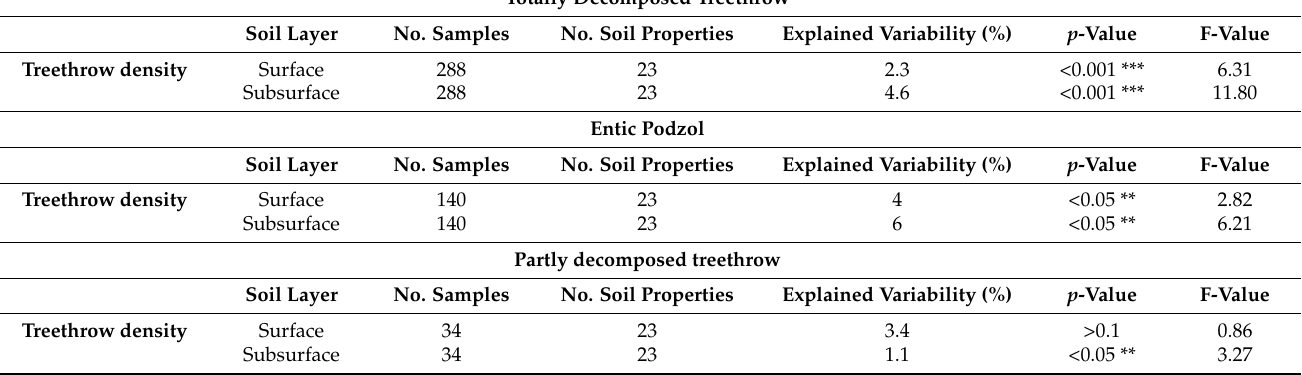
Table 6. Redundancy analysis (RDA). Pearson correlation coefficient for the relationship between treethrow density and treethrow depth, and soil chemical properties. No. samples indicates the number of plots in each category. Significant relationships are indicated in bold and marked according to their significance level: *** p < 0.001; ** p < 0.05. More information can be found in Table S4 in the Supplementary